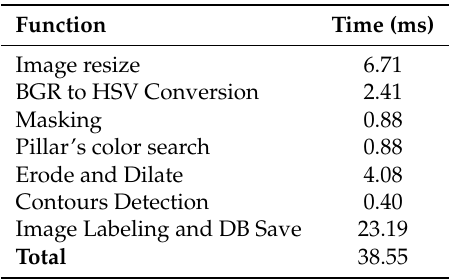
Table 1. Processing time of each frame for pillar